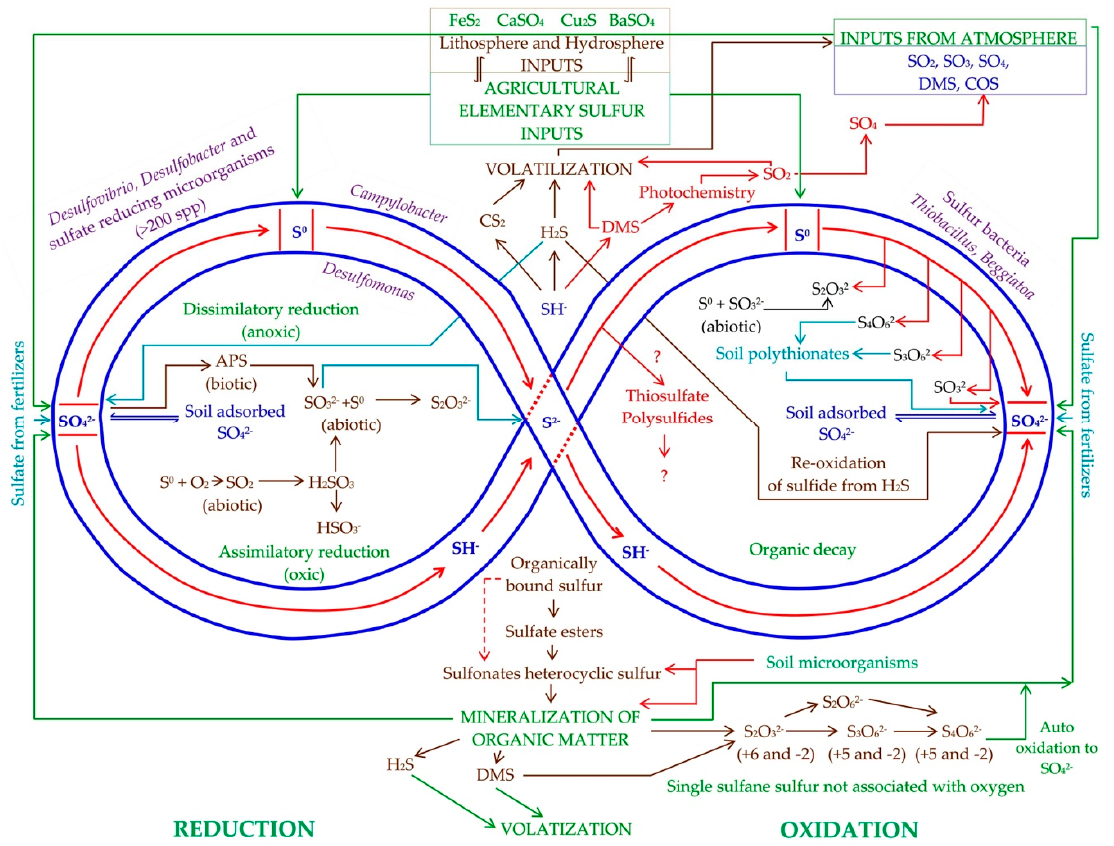
Figure 2. Schematic representation of the flow of sulfur in soil. APS = adenosine 5 ′ -phosphosulfate. Oxidation states of sulfur in the different molecules are: SO 42 − (+6); S 2 O 62 − (+5 and − 2); S 4 O 62 − (+5 and − 2); S 3 O 62 − (+5 and − 2); SO 32 − (+4); SO 2 (+4); S 2 O 32 − (+6 and − 2); COS (+2); S 0 (0); SH − ( − 2); S 2 − ( − 2); DMS ( − 2); CS 2 ( − 2).